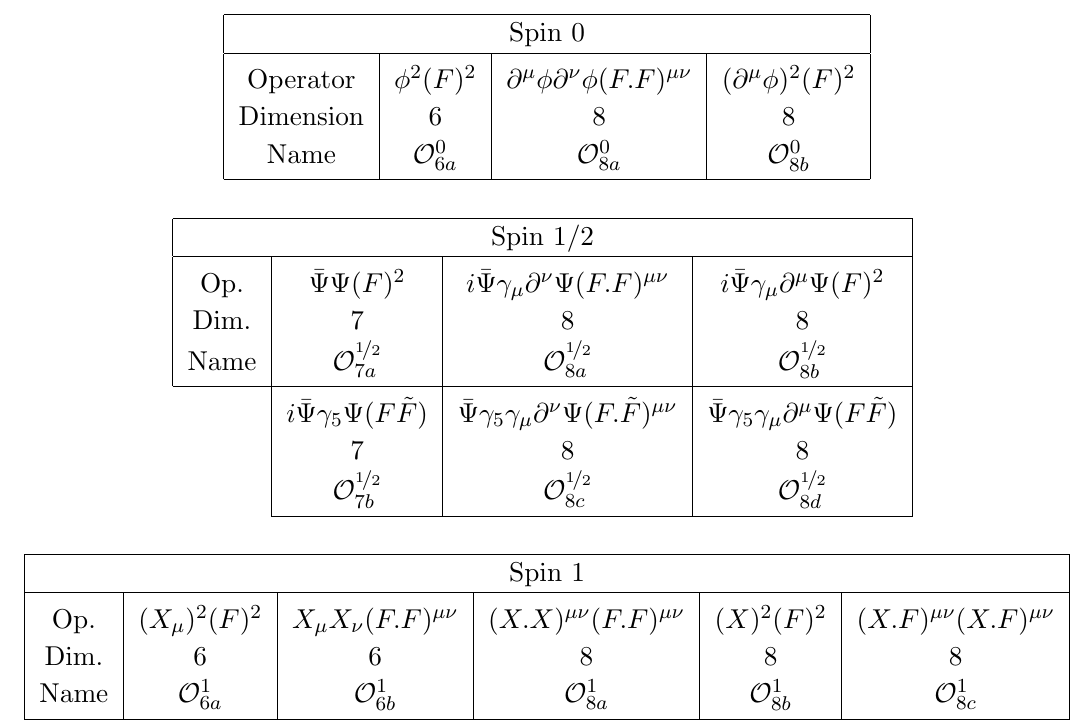
Table 1 . CP-even polarizability operators for a self-conjugate particle of spin 0, 1/2 and 1. The notations for the (cid:12)eld strength contractions of X are the same as for F